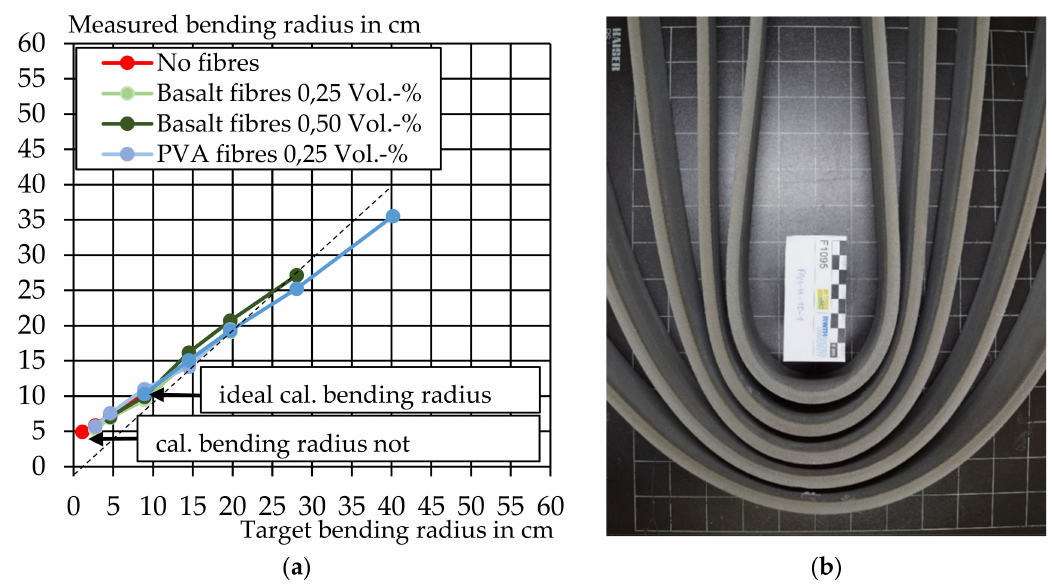
Figure 10. ( a ) Calculated target and the measured bending radius for the longitudinal forming of the extruded mortar specimens; ( b ) longitudinally formed mortar specimen without visible cracks (no fibres and no textile reinforcement).